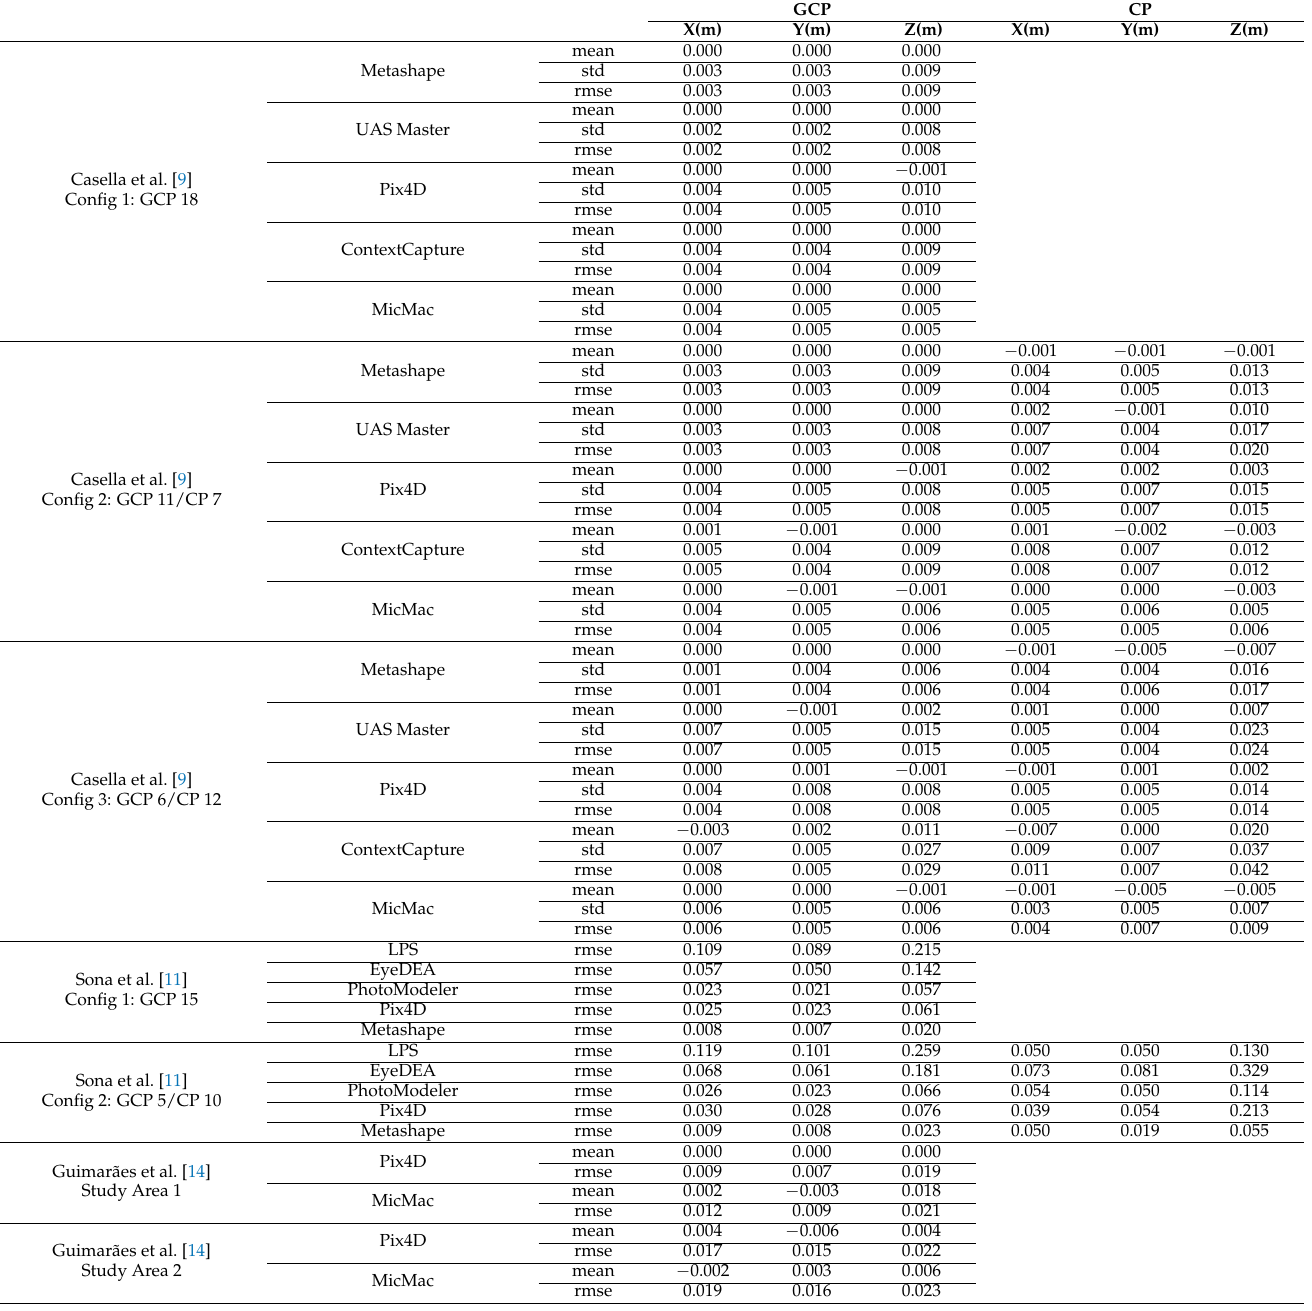
Table 3. A table with the error resulting from the comparison of different programs. Casella et al. and Sona et al. first configuration is used as a control configuration to calibrate the system. The next configurations are used to test different amount of GCP configurations using checkpoints as evaluating points. It is worth noting that Metashape allows a creation of a better fit of data model (lower RMSE values) although with a more balanced amount of GCP/CP (such as config 2 of Casella et al.), MicMac should be mentioned providing less error at the Z component as an open-source web program. In Guimarães et al., errors are quite similar between the two programs surveyed from two study